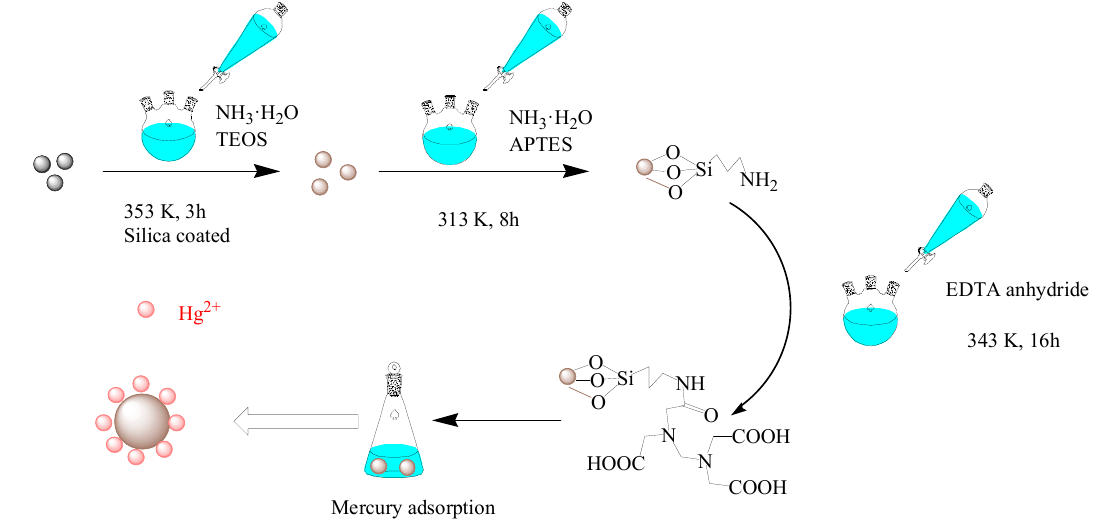
Figure 1. Synthesized schematic diagram of CoFe 2 O 4 @SiO 2 -EDTA in this experiment.